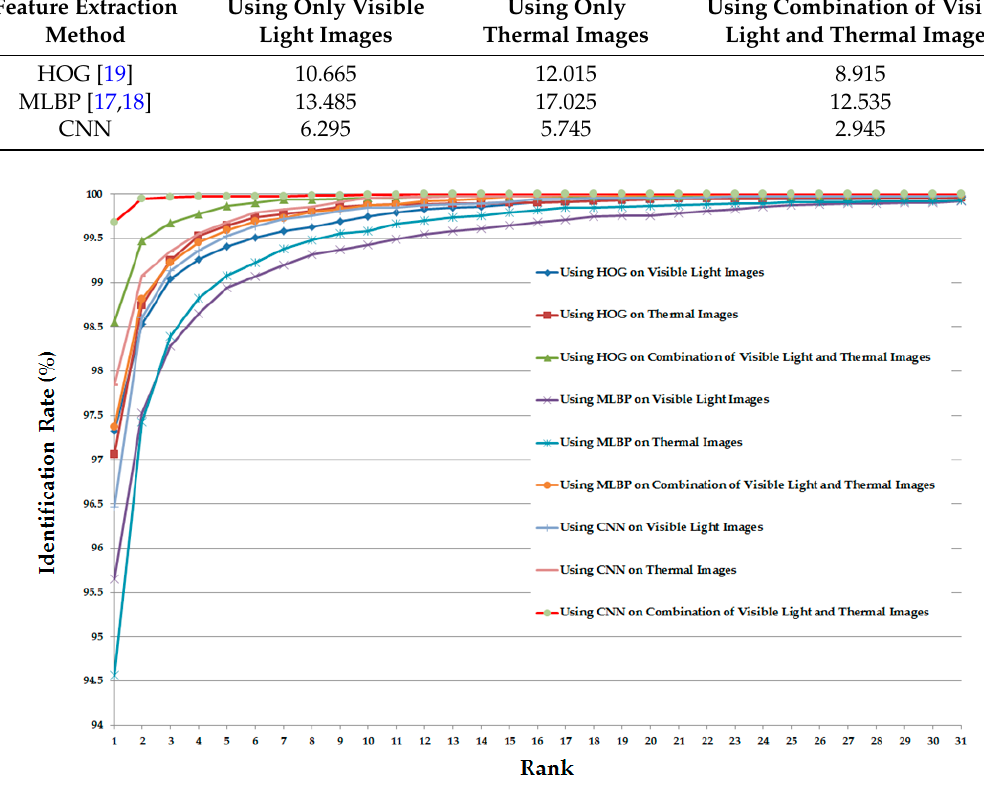
Figure 12. Cumulative matching characteristic curve (CMC) curves using Euclidean distance with various system configurations for the identification problem.